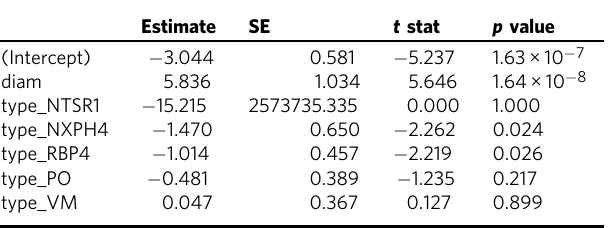
Fig. 4 A combination of diameter and neuronal subtype predicts myelination status. a Example segment of an axon imaged at high resolution for diameter analysis and corresponding MBP immunostaining. A small rectangle was used to plot a pro fi le of the average gray value intensity pro fi le across a few μ m of the axon (result shown in ( b )) to determine its diameter by the full width at half maximum (FWHM). Scale bar, 2 μ m. b Plot of the average pro fi le across the axon in ( a ). Each point represents the average gray value of a single pixel across the representative lines in ( a ), top panel. c Histograms of the proportions of axons myelinated (colored bars) or unmyelinated (gray bars) for different axon diameters. Note the color of overlapping bars is additive. d As in ( c ), pooled across all neuronal subtypes. e Probability distributions for the myelination probability of each neuronal subtype given a certain diameter. Points are individual axons myelinated. Intermediate probabilities (not 1 or 0) represent the average myelination status across at least three positions along the axon surveyed to calculate the average diameter. See text for details on probability functions. Source data and statistical tests are provided as a Source Data fi le. Table 4 Estimated coef fi cients for the generalized linear